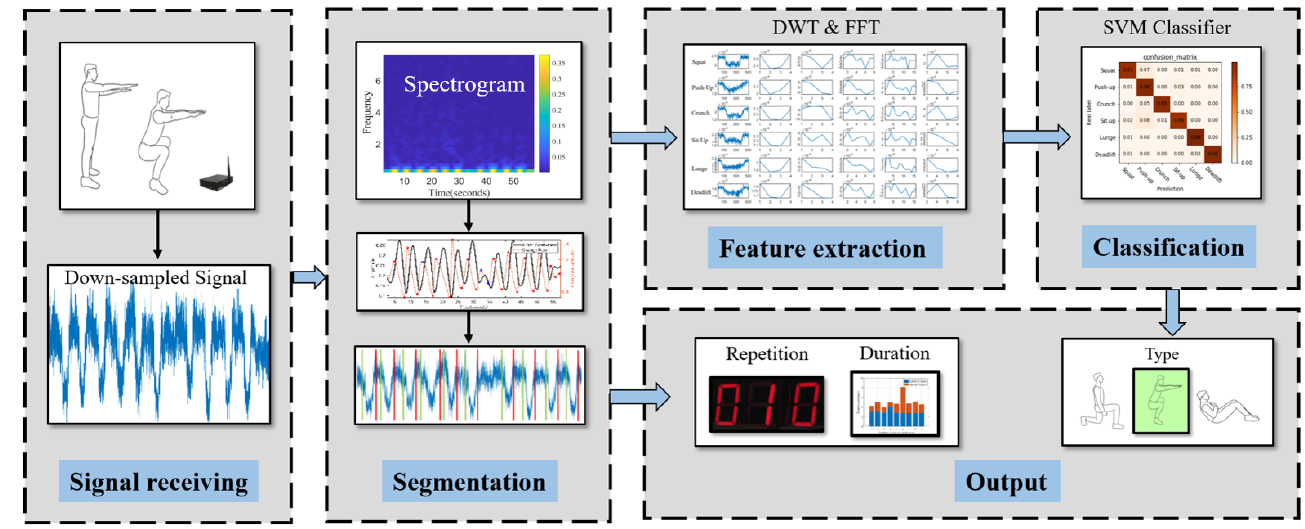
Figure 9. MobiFit framework with an example of a squat session [15].